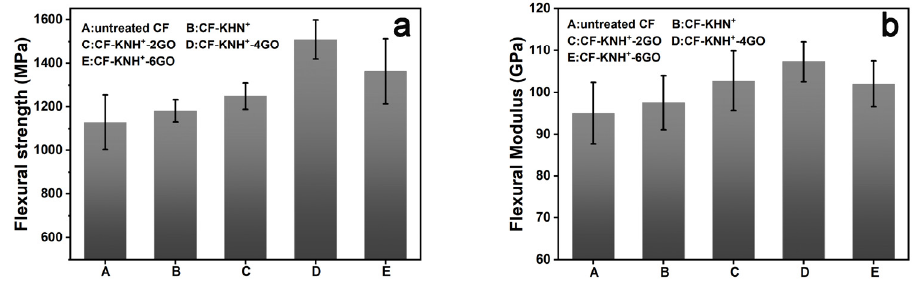
Figure 8. ( a ) Flexural strength of GO/CF multiscale composites and ( b ) Flexural Modulus of GO/CF multiscale composites.